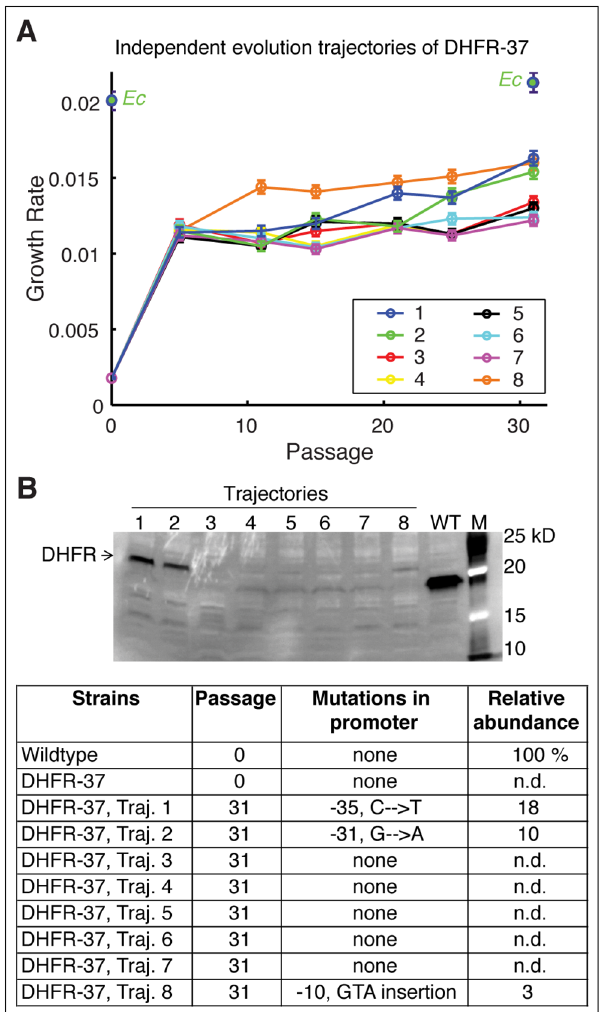
Fig 6. Fine-tuning evolution of orthologous DHFR expression. A) Eight independent evolutionary trajectories of DHFR-37 (from P . ananatis ) show an increase in fitness after evolution. Growth rates of each individual trajectories were measured every 5 passages. Three trajectories (1, 2, and 8) become markedly fitter than the rest after 31 passages. Error bars represent standard deviation of 4 independent measurements. B) Soluble abundance of DHFR-37 protein was measured in soluble cell fractions of all eight trajectories after evolution (In the gel, M: Marker). Note the pronounced abundance levels in trajectories 1, 2, and 8. N.d. not detected. Sequencing of folA gene revealed characteristic mutations in the promoter region that explain the increased abundance and improved